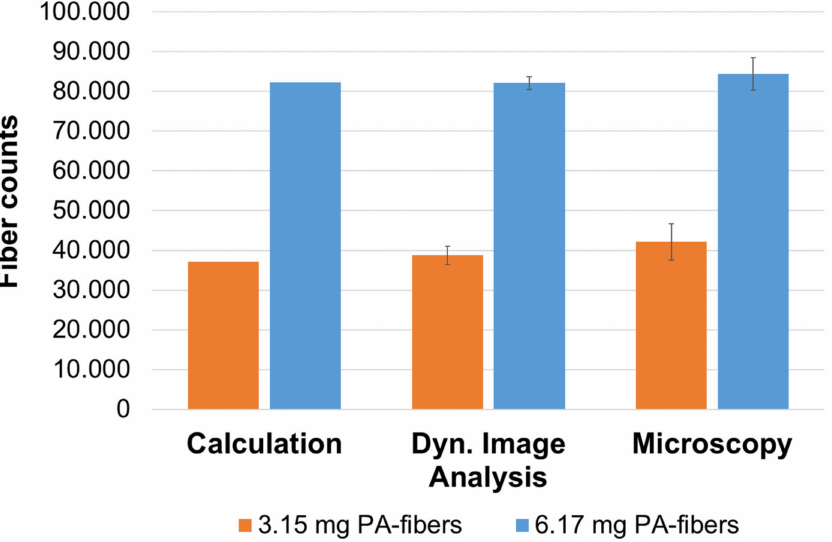
Figure 5. Results of the quantitative fiber determination of suspended polyamide 6.6 (PA-) fibers (0.3 mm length, 1.7 dtex). The fiber counts were determined for 3.15 and 6.17 mg fiber suspensions respectively by three methods: calculation of the theoretical number of fibers, dynamic image analysis and optical microscopy